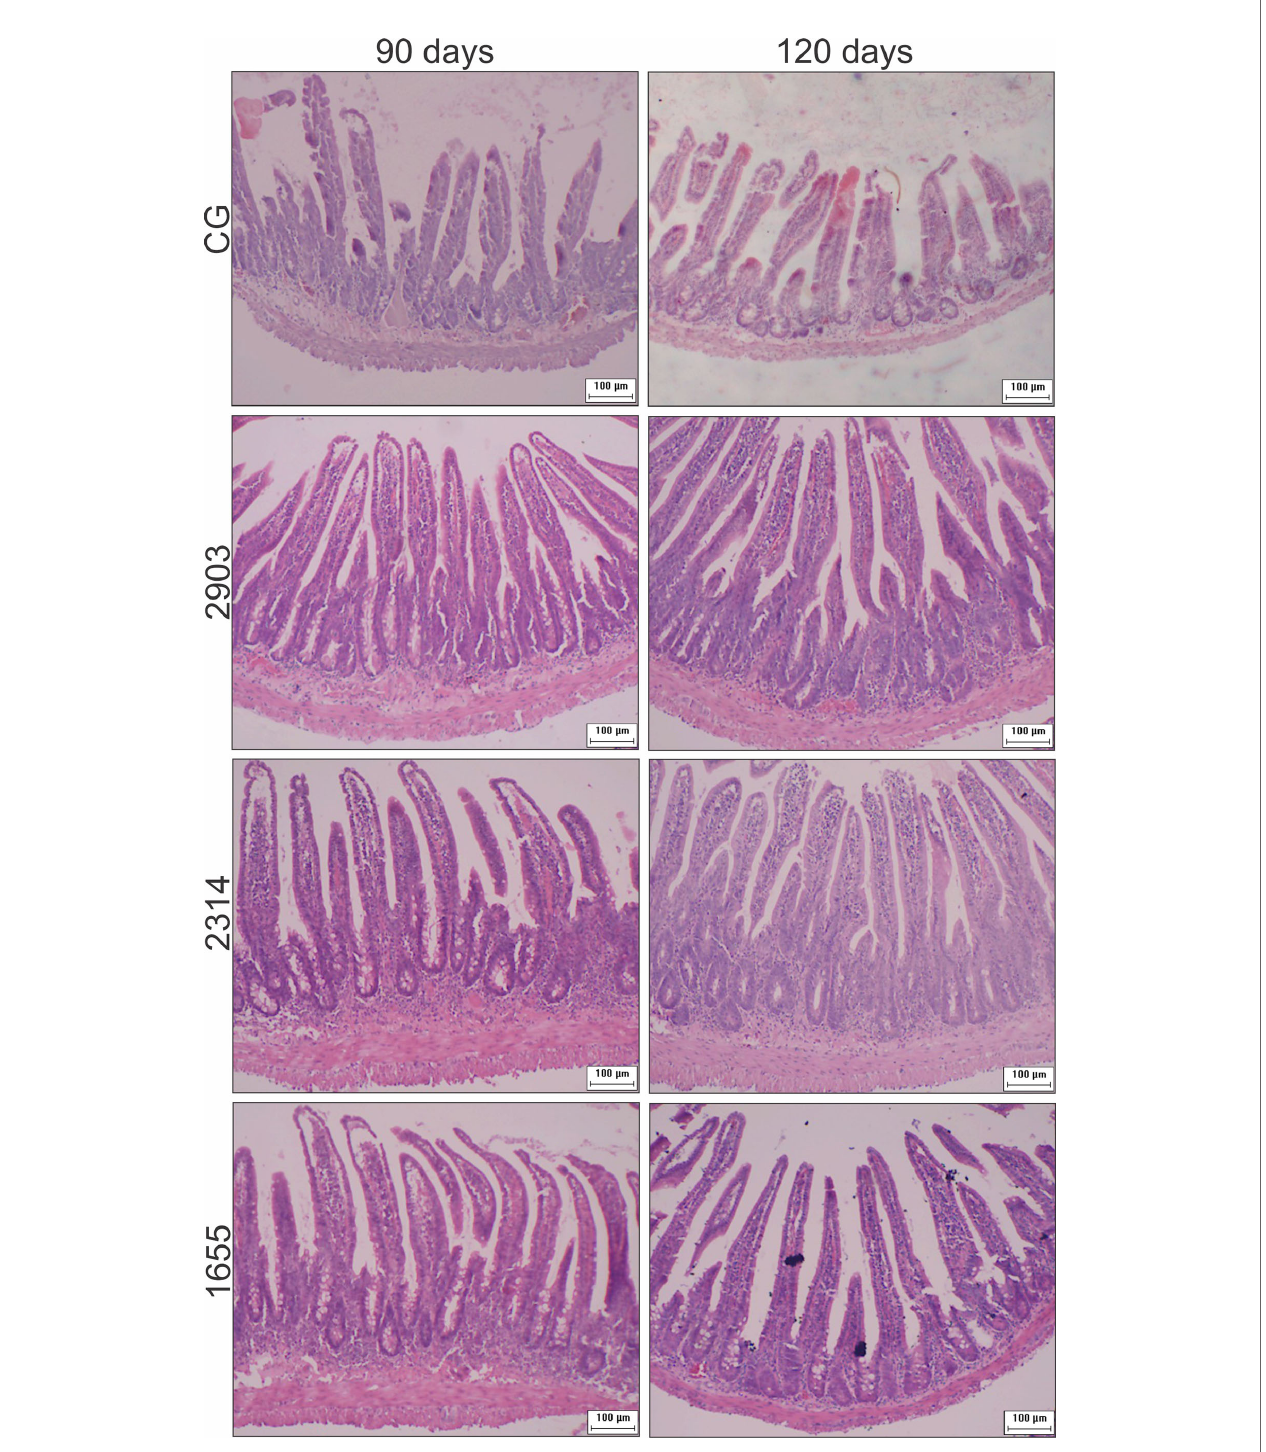
FIGURE 5 | Photomicrograph of cross-sections representing the ileum wall, villi, and crypts of hamsters infected by L. (V.) braziliensis (HE staining, 10× magni fi cation, scale bar = 100 μm, Olympus CX31). CG, control group. 2903: group infected with MHOM/BR/1975/M2903. 2314: group infected with MHOM/BR/ 2003/2314. 1655: group infected with MHOM/BR/2000/1655.